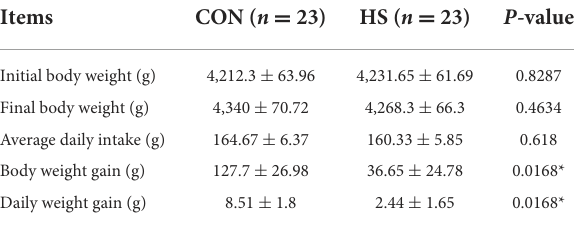
TABLE 1 Growth performances for female rabbits ( n = 23 per group) in 15 days, as affected by HS.